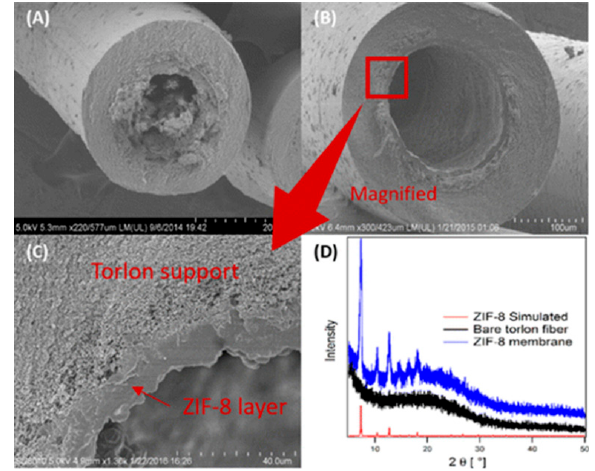
Figure 66. Cross-sectional SEM images of ( a ) Case 2 ZIF-8 hollow fiber membrane showing crystal overgrowths inside the fiber bore; ( b , c ) Case 3 ZIF-8/hollow fiber membrane; and, ( d ) XRD patterns of bare PAI membrane and Case 3 ZIF-8 membrane, with a simulated XRD pattern of ZIF-8 shown for comparison (adapted with permission from ref. [165]).